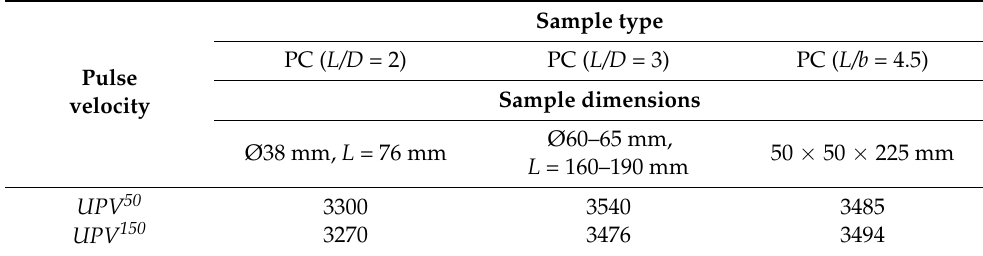
Table 1. The results of ultrasonic pulse velocity measurements in polymer concrete samples of different geometry